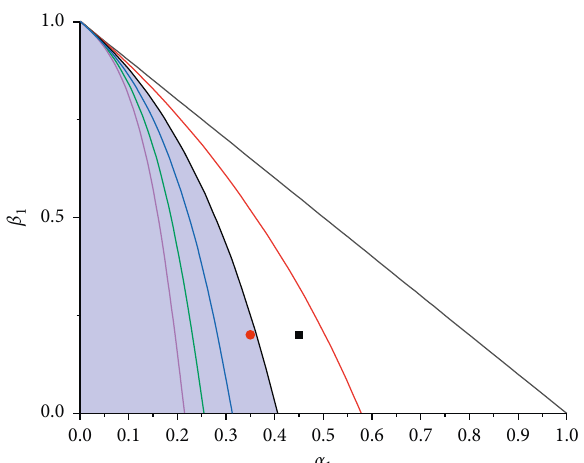
Figure 2: The phase diagram, obtained in [2], shows the line of divergence of moments in a GARCH-normal (1,1) model. The highlighted area shows the existence region for the sixth-order moment. The red circle presents an example of α allow for the second-, fourth-, and sixth-order moments to exist, whilst the black square shows an example of α for only the second- and fourth-order moments to